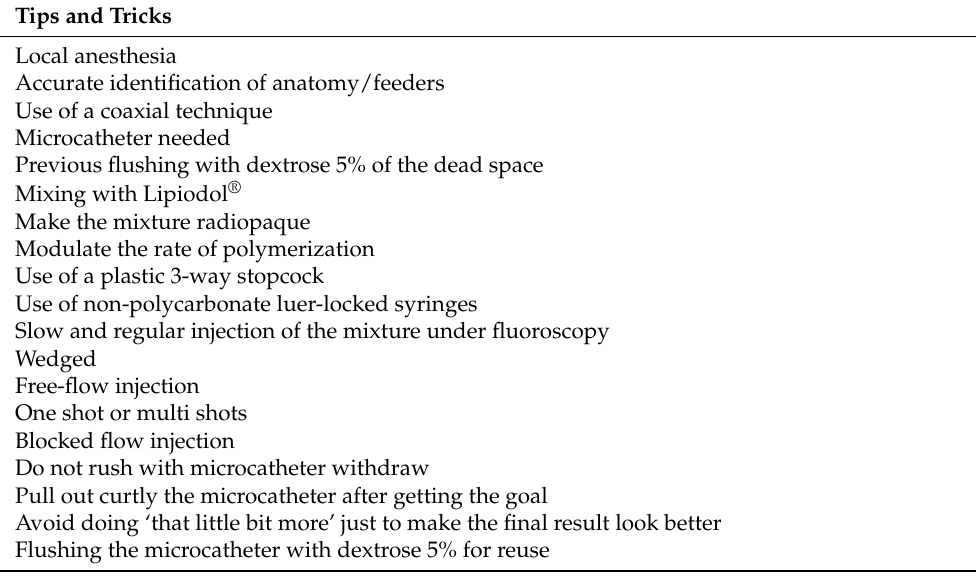
Table 4. Tips and tricks overview for cyanoacrylate procedure